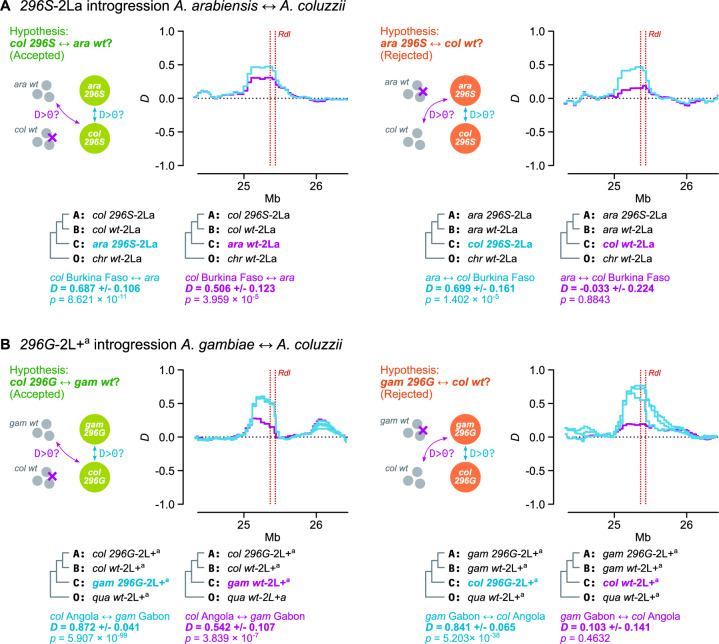
Interspecific introgression. (A) Direction of 296S introgression between Anopheles arabiensis and A. coluzzii (2La/ 2La background). We test two complementary hypothesis using Patterson’s D statistics: left, introgression between A. coluzzii 296S homozygotes (population A), A. coluzzii wt (B), and A. arabiensis (296S or wt; C) using A. christyi as outgroup (O); right, reversing the position of A. coluzzii and A. arabiensis as populations A/B and C. The complementary hypotheses can be summarized as follows: if 296S homozygotes from species i show evidence of introgression with wt homozygotes from species j (first test) but not with wt from species i (second test), 296S originated in species j. (B) Direction of 296G introgression between A. gambiae and A. coluzzii (2L+a/2L+a background), testing two complementary hypothesis using Patterson’s D statistics: left, introgression between A. coluzzii 296G homozygotes (population A), A. coluzzii wt (B), and A. gambiae (296G or wt; C) using A. quadriannulatus as outgroup (O); right, reversing the position of A. coluzzii and A. gambiae as populations A/B and C. Color-coded cladograms at the bottom of each plot indicate the groups of specimens used in each test, including the average D in the Rdl locus with SEs and P values (estimated from the Z score of jack-knifed estimates; see Materials and Methods). See detailed lists of comparisons and statistical analyses in supplementary materials SM12 and SM13, Supplementary Material online.